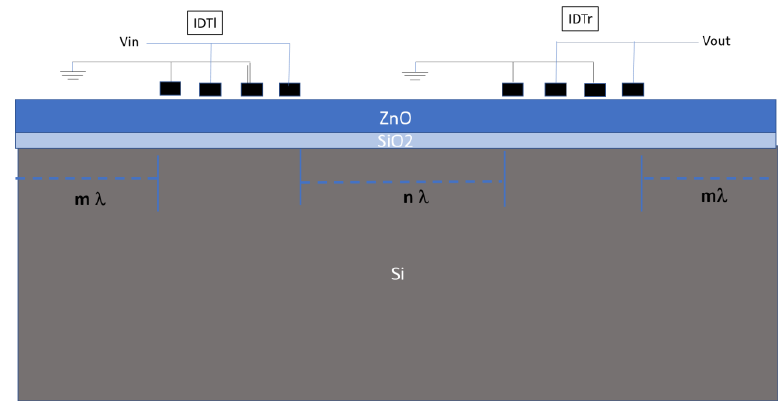
Figure 8. The schematic of the delay line model adopted for the time domain study.